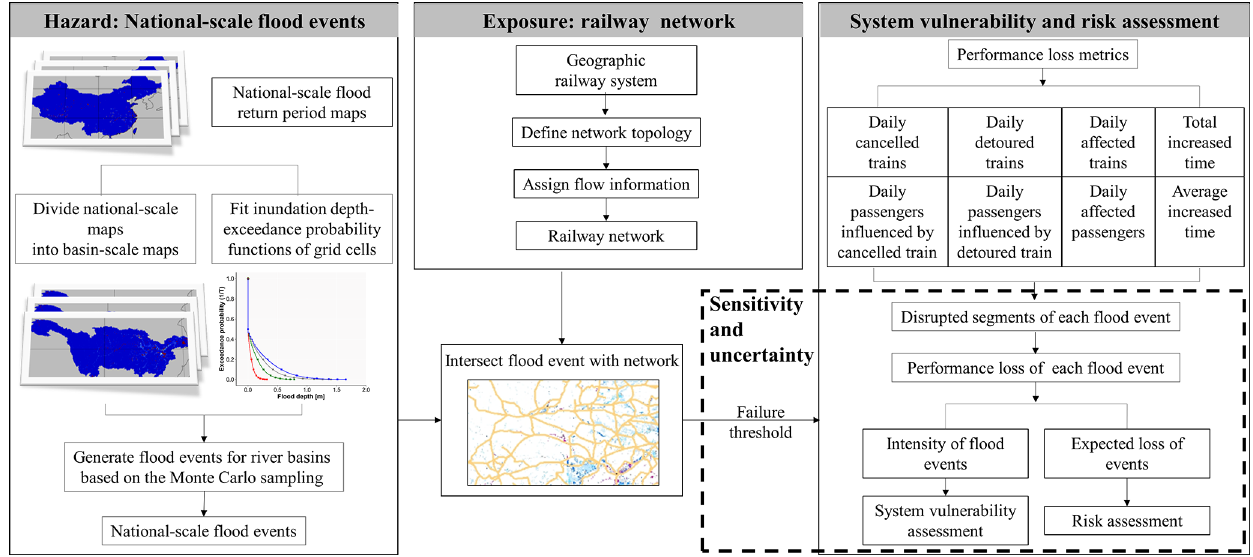
Figure 2. Methodology of the flood system vulnerability and risk assessment of railway infrastructure. Railway geometries © OpenStreetMap contributors 2019. Distributed under the Open Data Commons Open Database License (ODbL)